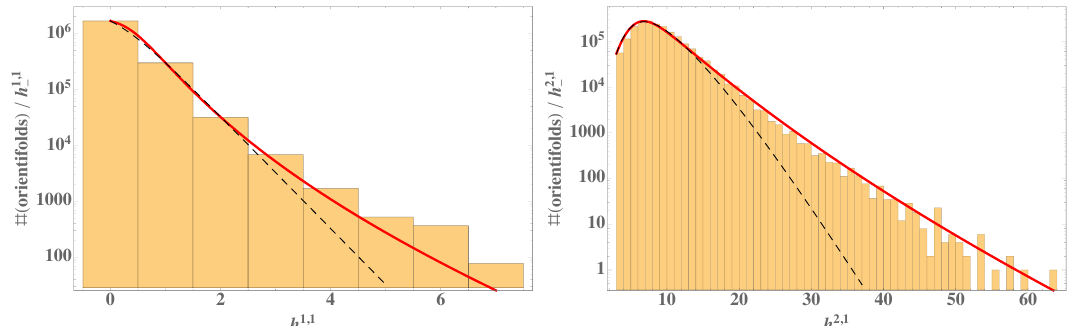
Figure 1 . Histogram showing the number of orientifolds with given h 1 ; 1 (left) and h 2 ; 1 (right) on a (cid:0) (cid:0) logarithmic scale. Black dashed curve: (cid:12)t with #( h i; 1 ) / ( h i; 1 ) p i = ( b i + e c i h i; 1 (cid:0) ), p 1 = 0. Red curve: (cid:0) (cid:0) q h i; 1 (cid:0) ), p (cid:12)t with #( h i; 1 ) / ( h i; 1 ) p i = ( b i + e c i 1 = 0. The latter (cid:12)t results in parameter estimates (cid:0) (cid:0) ( b 1 ; c 1 ) (cid:25) (71 ; 5 : 8) and ( b 2 ; c 2 ; p 2 ) (cid:25) (5 : 9 (cid:2) 10 (cid:0) 5 ; 3 : 9 ; 3 : 1). It is clear that the distributions of h i; 1 (cid:0) have a tail heavier than exponential fall-o(cid:11) (compare e.g. [26]).